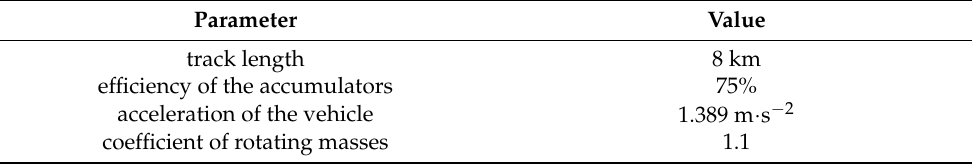
Table 4. Selected parameters for calculating the energy for driving the